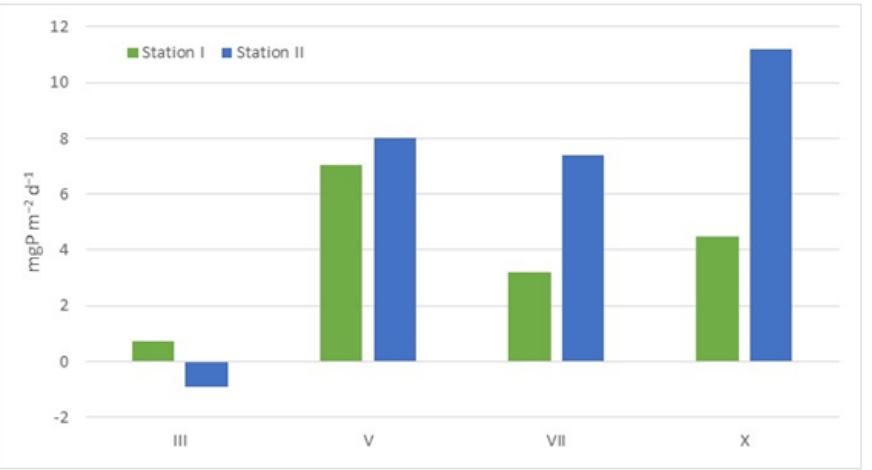
Figure 4. Seasonal changes of domination of phosphorus release (positive values) or accumulation in bottom sediments (negative values) of Raczyńskie Lake at both sampling stations .